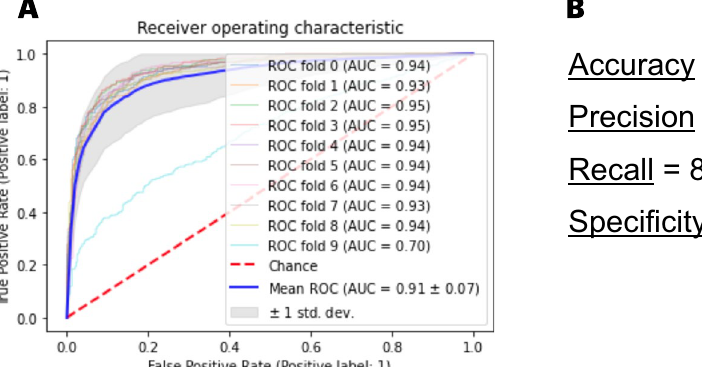
Figure 1. Results of archaeal promoter classification with support vector machines using the rbf kernel. In ( A ) we show the receive operator characteristic curve of a SVM with the RBF kernel in classifying archaeal promoter sequences. A stratified tenfold cross validation procedure was performed to grant statistical validity to the findings. We also calculate the area under the curve (AUC) of each fold, which generated a mean AUC of 0.91 ± 0.07. In ( B ), we show the averaged classification performance of the classificatory model within the metrics accuracy, precision, recall, and specificity for the test dataset. The values displayed are averaged upon the 10 folds of the cross validation.